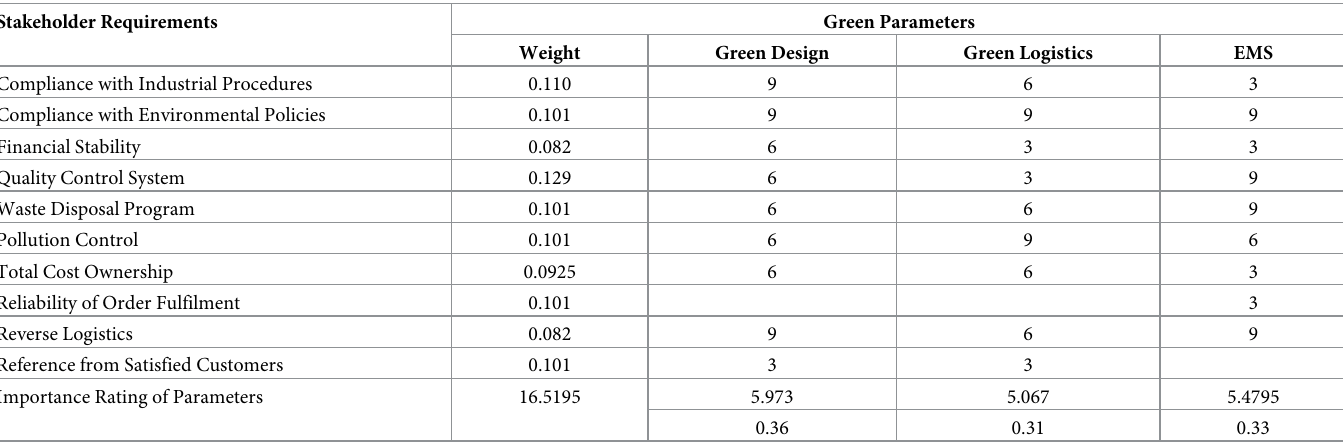
Table 5. House of quality